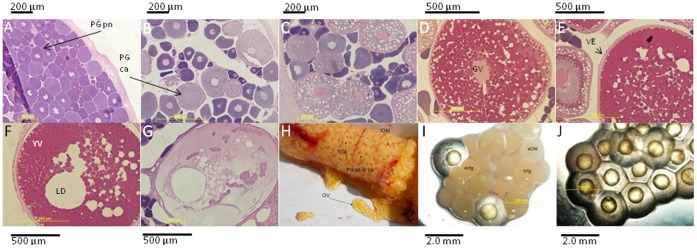
Representative ovarian stages used to characterize gonad phase.(A) primary growth perinuclear (PG pn), (B) primary growth cortical alveoli (PG ca) (C) secondary growth early vitellogenesis (SG eVtg), (D) secondary growth late vitellogenesis (SG lVtg) (E) early oocyte maturation (SG eOM), (F) late oocyte maturation (lOM) (G) Atresia (AT) (H) external morphology of the heterogeneous LMB ovary, (I) oocytes at various stages of development, and (J) ovulated eggs that have not been water hardened. Additional abbreviations are as follows: Germinal Vesicle (GV), Lipid Droplet (LD), Vitelline Envelope (VE), and Yolk Vesicles (YV). Scale bars correspond to 200 µm (A–B) and 500 µm (C–F).